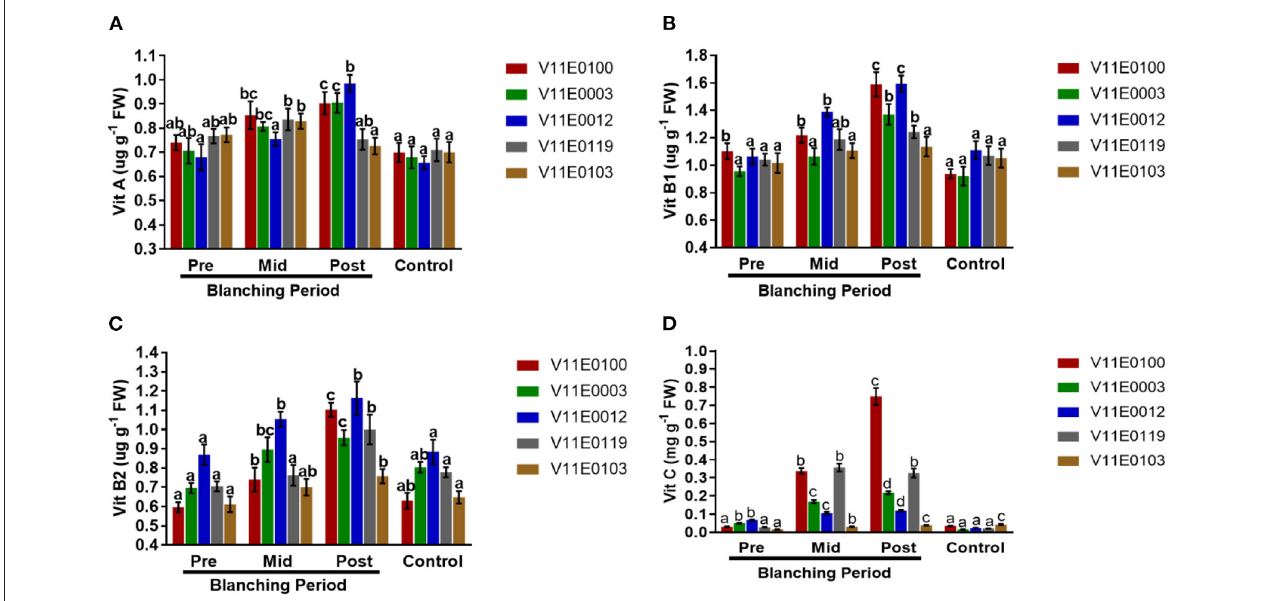
FIGURE 8 | Effect of blanching on the content of vitamins in the stem of five water dropwort cultivars. (A) Vitamin A content, (B) Vitamin B1 content, (C) Vitamin B2 content, and (D) Vitamin C content. Four types of samples were analyzed; Pre-blanching, Mid-blanching (20 days), Post-blanching (40 days), and Control (grown under normal conditions). Different letters indicate a significant difference ( P < 0.05) among the treatments according to the Tukey test. Values are means ±